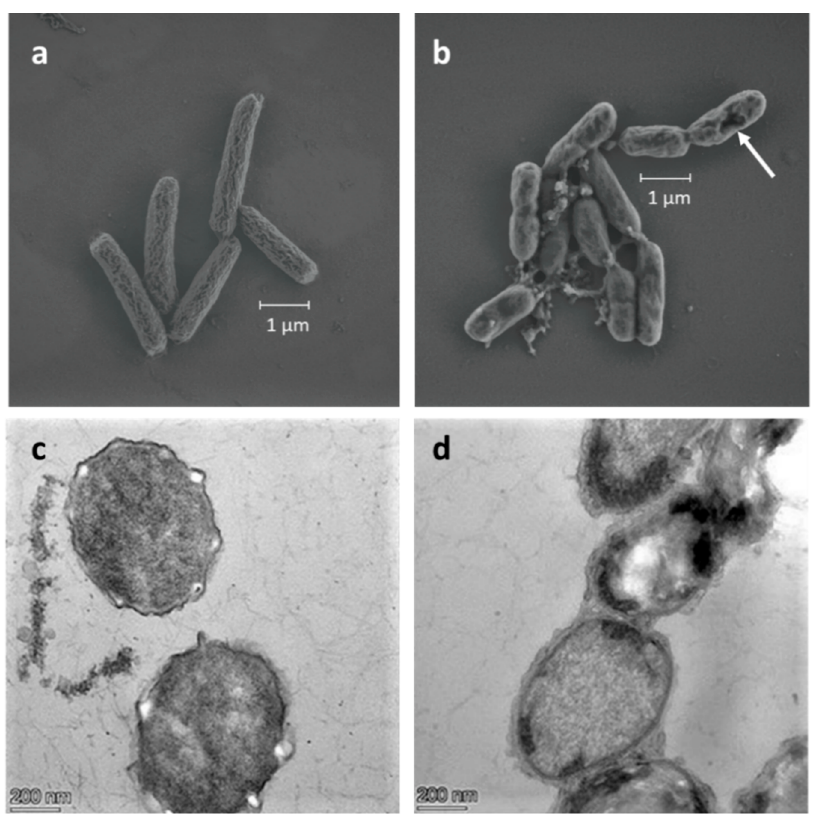
Figure 5. ( a ) SEM images of free E. coli cells and ( b ) 3-layers LbL biohybrid capsules. Arrows indicate damage seen in bacterial envelope. ( c ) TEM cross-section images of free E. coli cells and ( d ) 3-layers LbL biohybrid capsules.